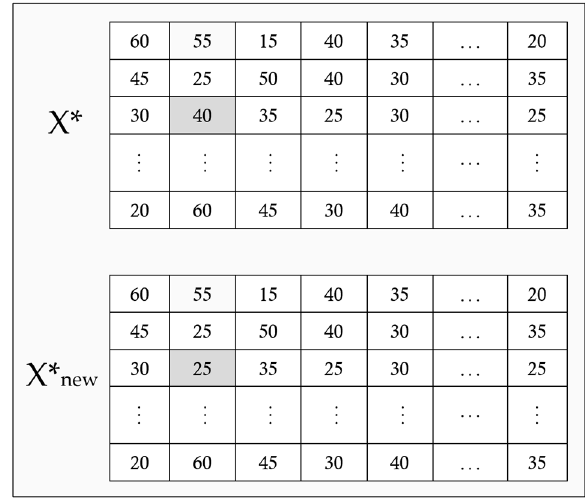
Figure 4. An example of integer local search for S. 𝑅 (cid:3036)(cid:3037)(cid:3039) .